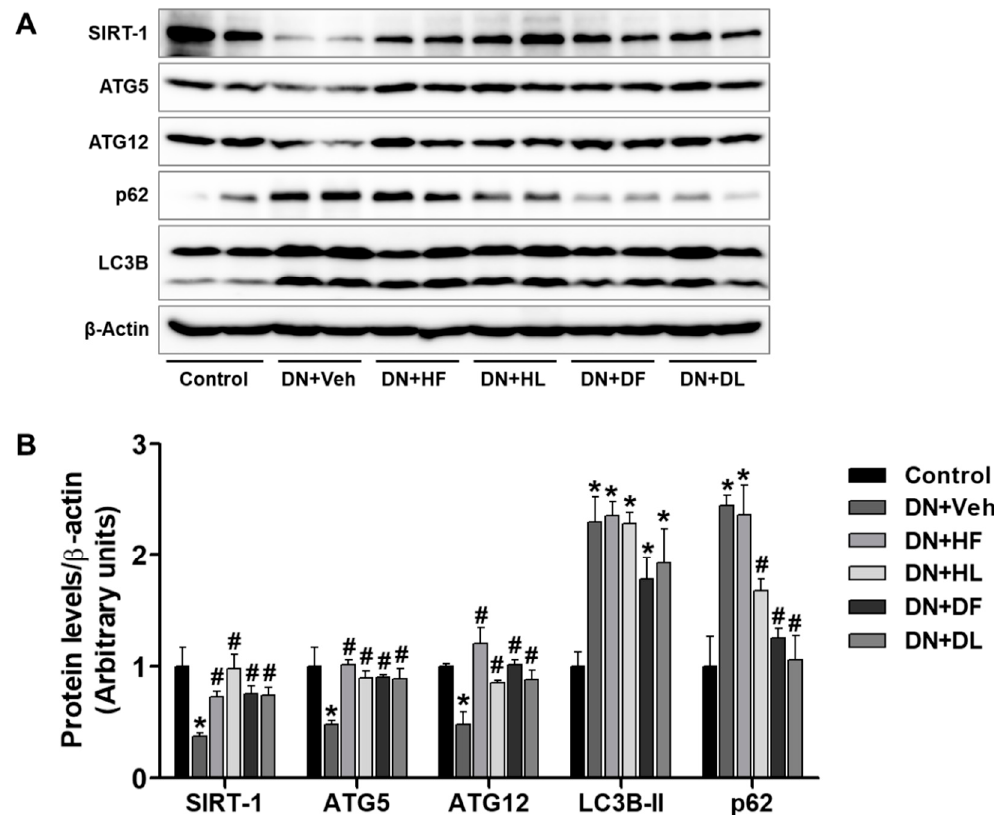
Figure 6. AM extract treatment changed hepatic expression of autophagy proteins in DN mice. Hepatic tissues were lysed for Western blot analysis and protein expression levels of SIRT-1, ATG5, ATG12, p62, and LC3B, which are shown ( A ). The quantitative analysis is included ( B ). The data are presented as the mean ± SEM. * p < 0.05 versus control, # p < 0.05 versus DN mice.